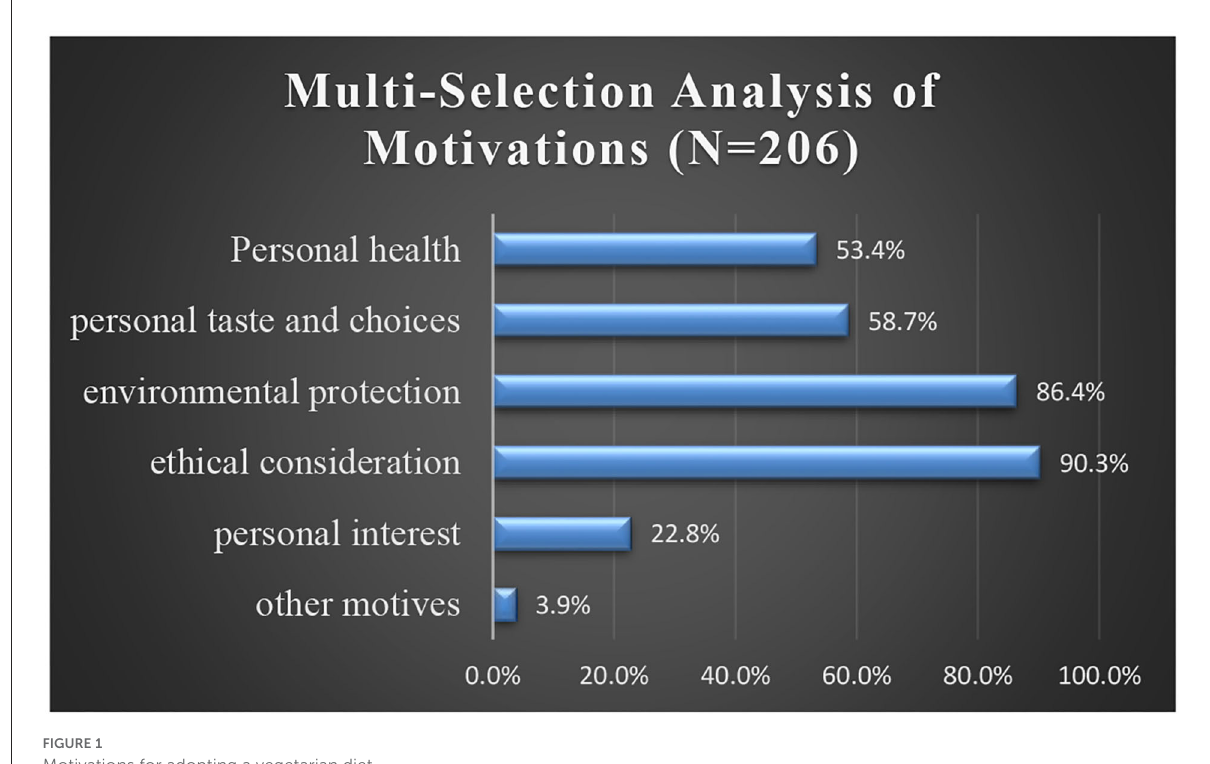
FIGURE1 Motivations for adopting a vegetarian diet.